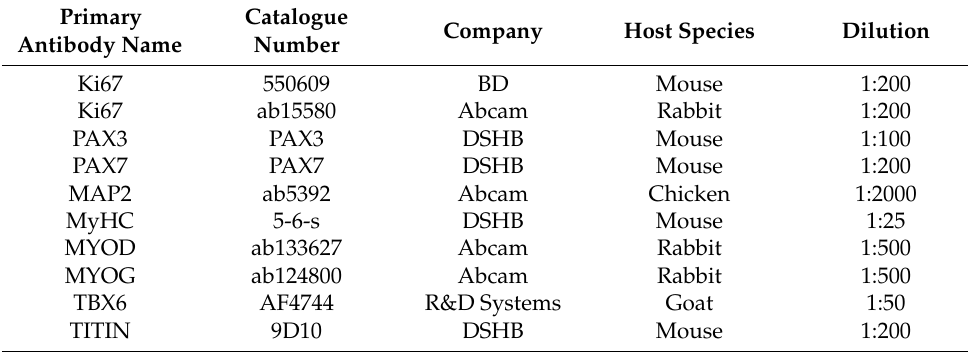
Table 1. Antibodies for immunofluorescence